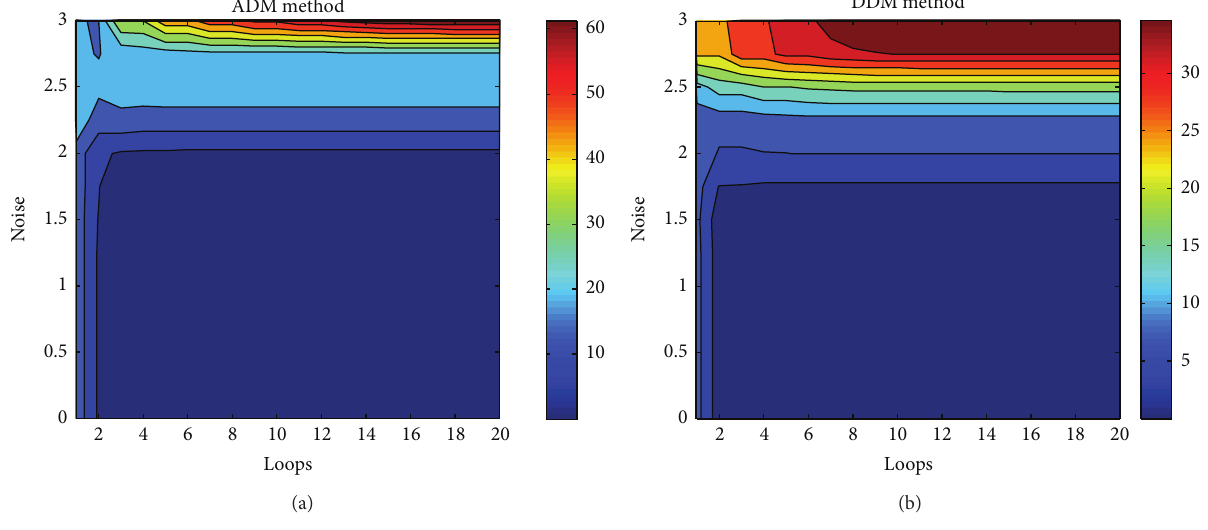
Figure 10: RPE contours with respect to noise level and loops.